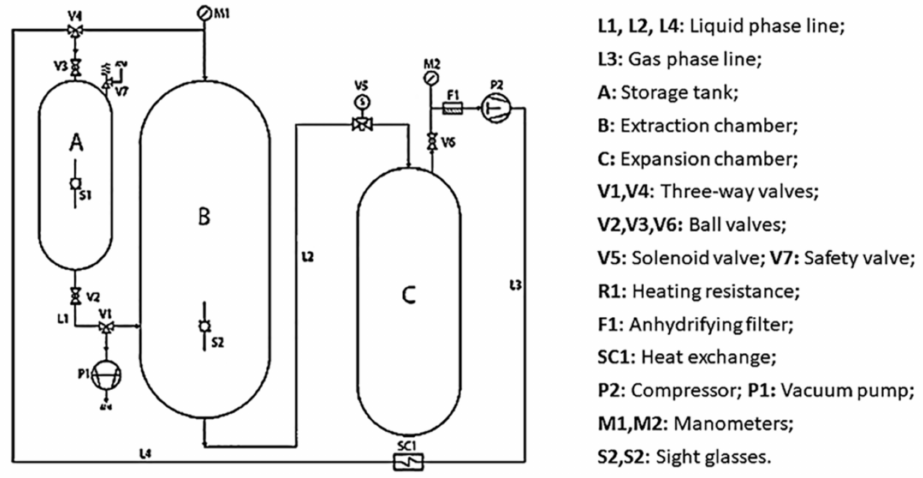
Figure 1. A schematic representation of the extraction plant using Norflurane as solvent